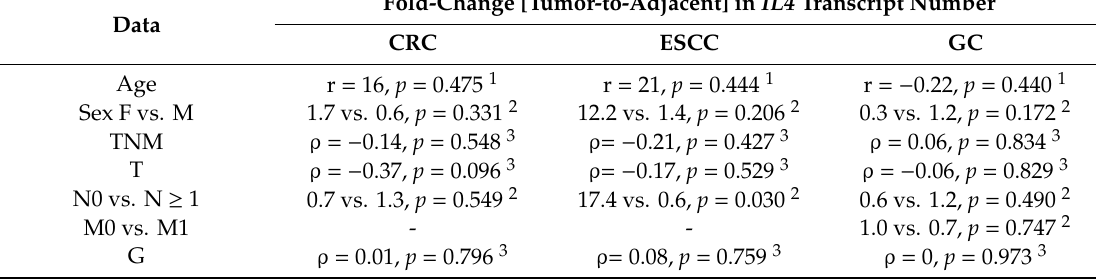
Table 4. Association of demographic and pathological data with IL4 mRNA expression in the GIT cancer patients.